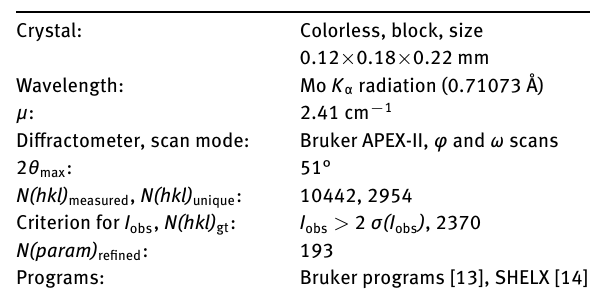
Table 2: Fractional atomic coordinates and isotropic or equivalent isotropic displacement parameters (Å 2 ).